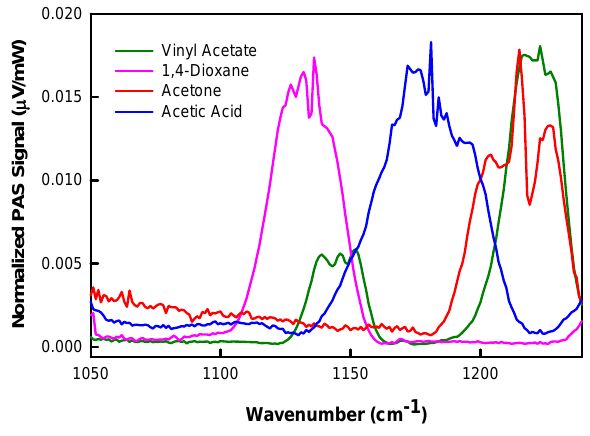
Figure 6. Laser photoacoustic spectral absorption features of acetic acid, acetone, 1,4-dioxane, and vinyl acetate in the 1050 cm -1 –1240 cm -1 (9.52 µm–8.06 µm) region. The spectra have been